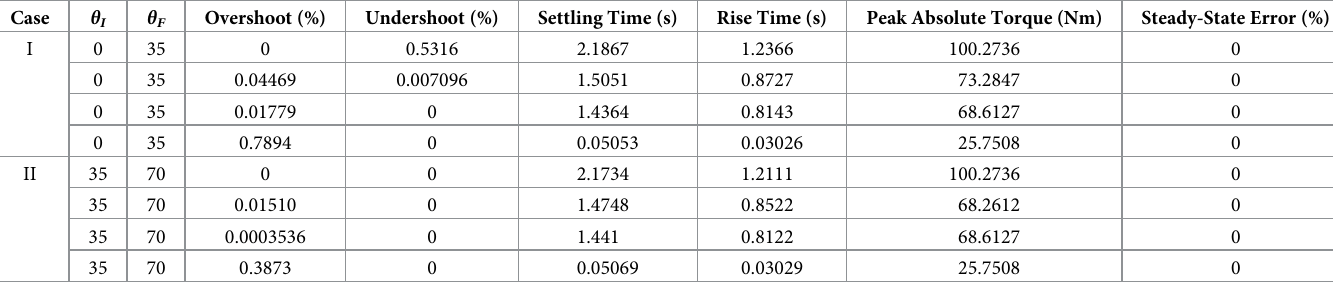
Table 4. Summary of results for SFG-SISO PI controllers.